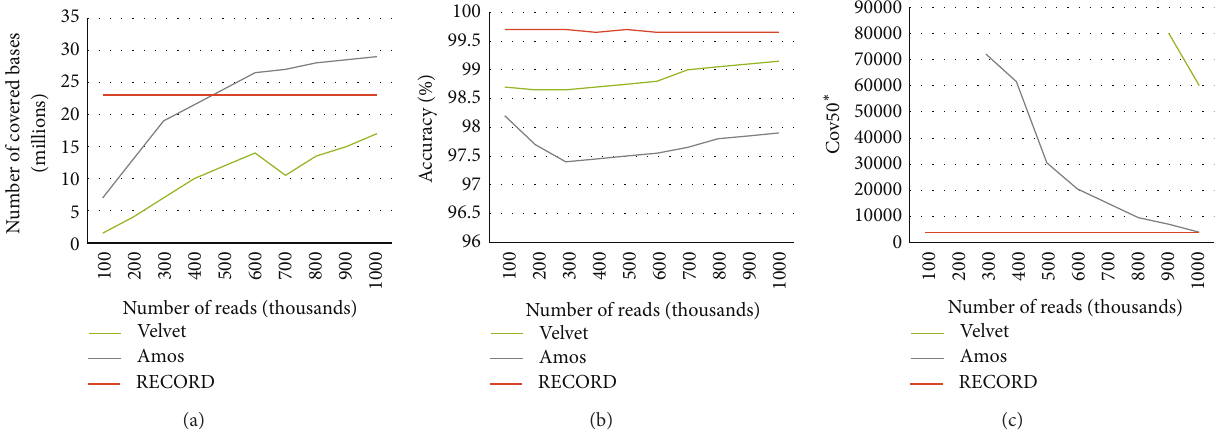
Figure 4: Comparison of the proposed approach (RECORD) with two state-of-the-art genome assemblers on data simulated with wgsim. In this experiment, we consider the evolved genome produced by Evolver as the target genome; the reference genome is the ancestral genome. The diagrams show the performance of the examined approaches according to various criteria as the function of the number of simulated reads that were used for the assembly. The diagram (a) shows the number of covered bases of the target genome; the diagram (b) shows the accuracy, that is, overall percentile identity between the assembly contigs and the corresponding segments of the target genome, while the diagram (c) shows the number of those largest contigs that together cover at least 50% of the target genome.